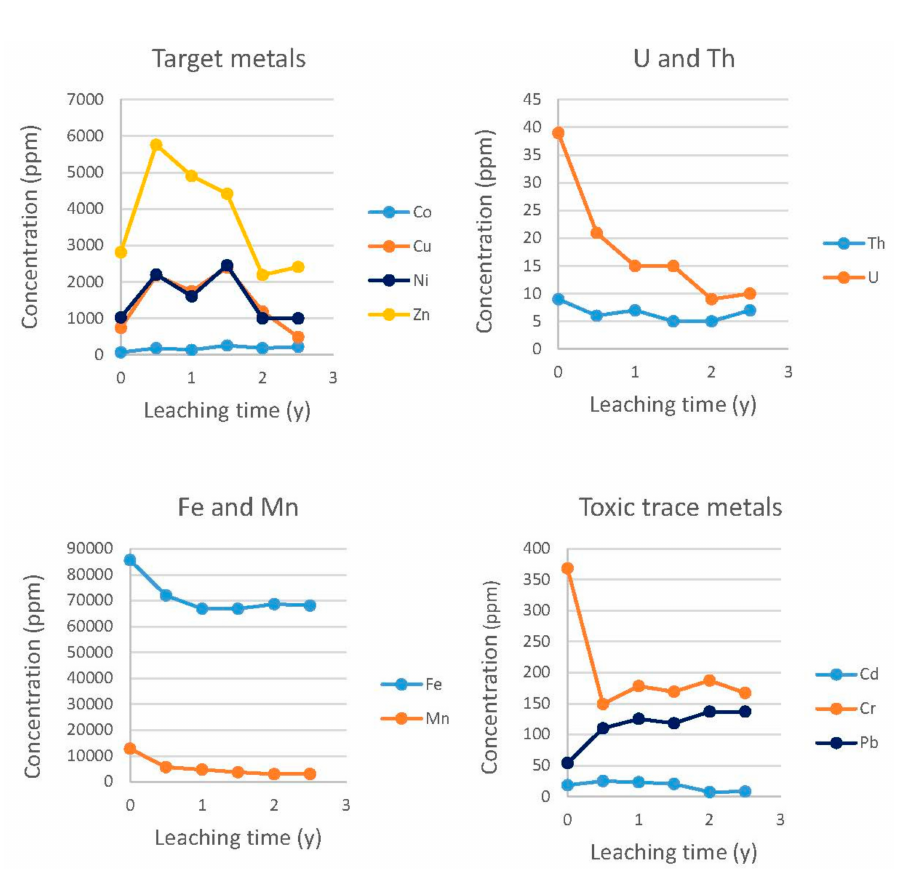
Figure 2. Concentration (ppm) of metals in the unprocessed Talvivaara ore and in the leaching heaps as a function of leaching